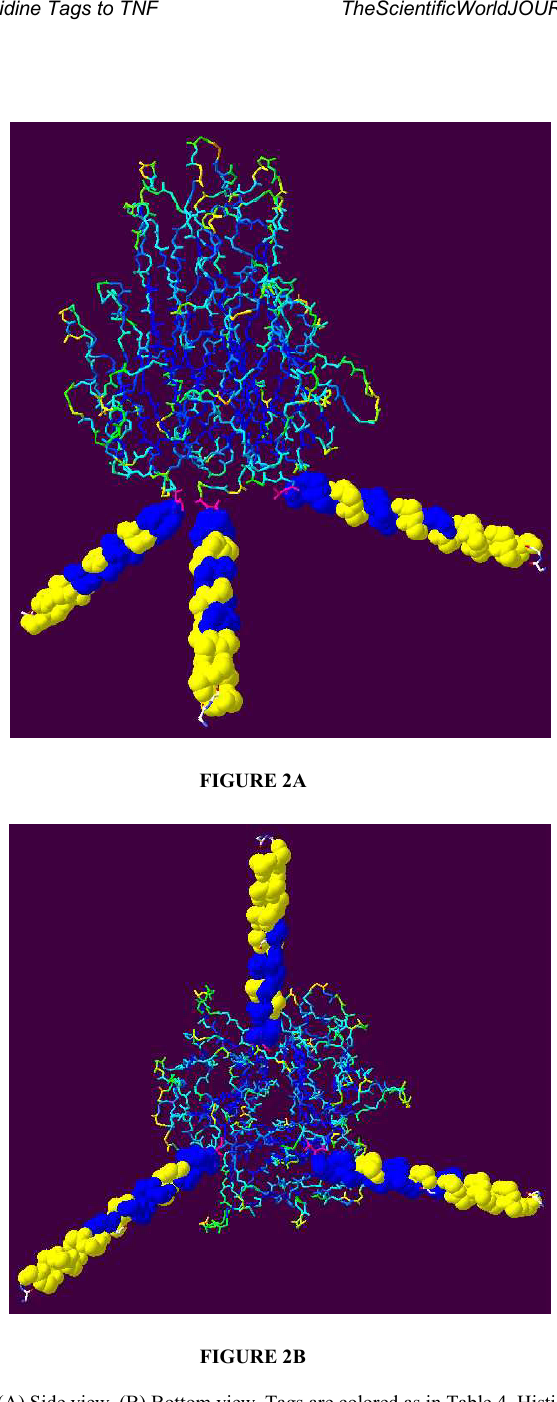
FIGURE 2. Model of His10-TNF. (A) Side view. (B) Bottom view. Tags are colored as in Table 4. Histidines and hydrophobic amino acid residues are in yellow, while hydrophilic (charged and polar) residues are in blue. Protein backbone is colored by accessibility: blue (interior) and green/yellow